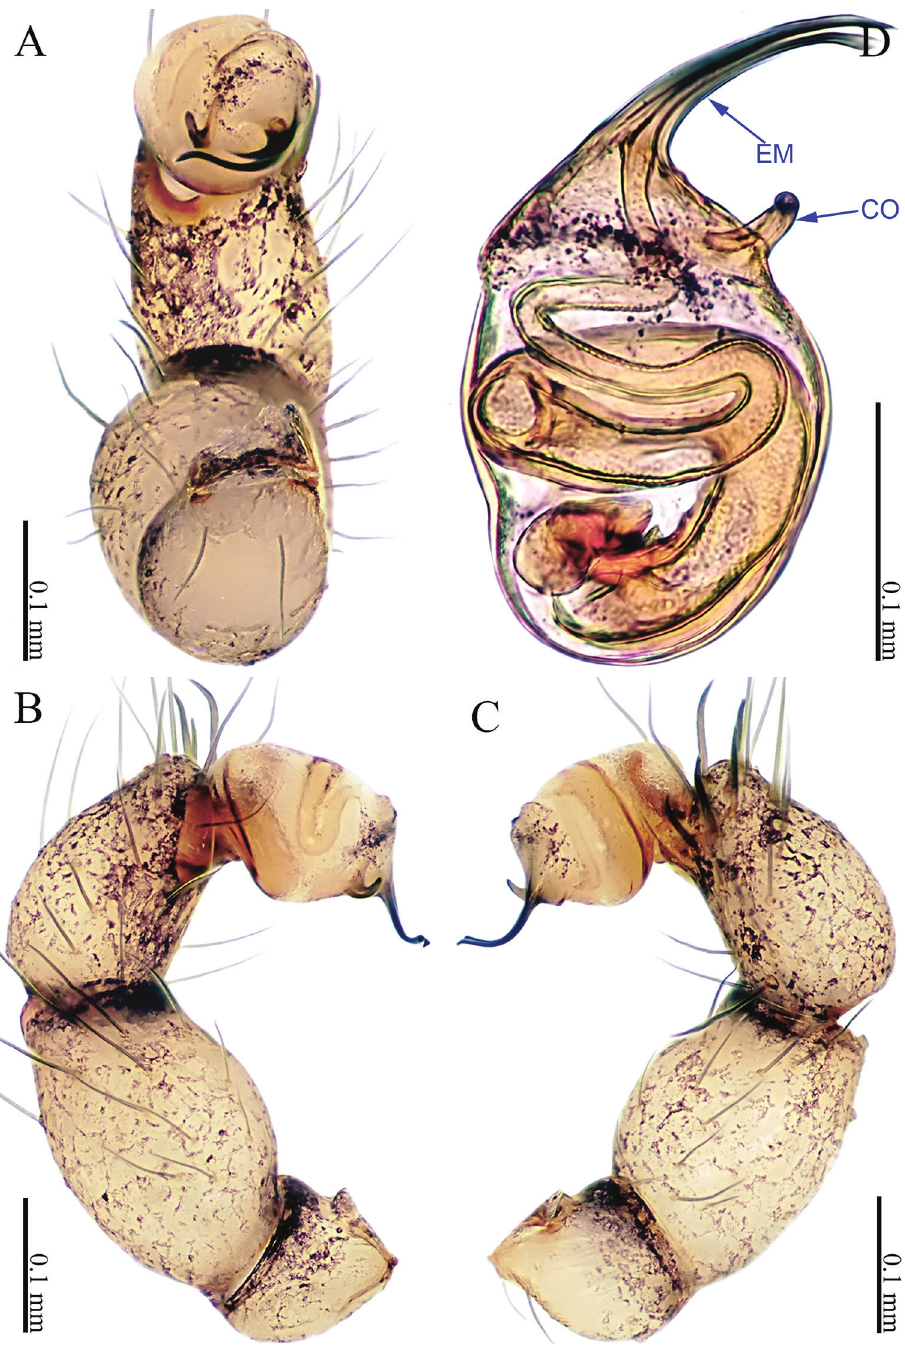
Figure 9. Sinoderces xueae Li & Li, sp. nov., male holotype A palp, ventral view B palp, prolateral view C palp, retrolateral view D palpal bulb, ventral view Abbreviations: CO conductor, EM